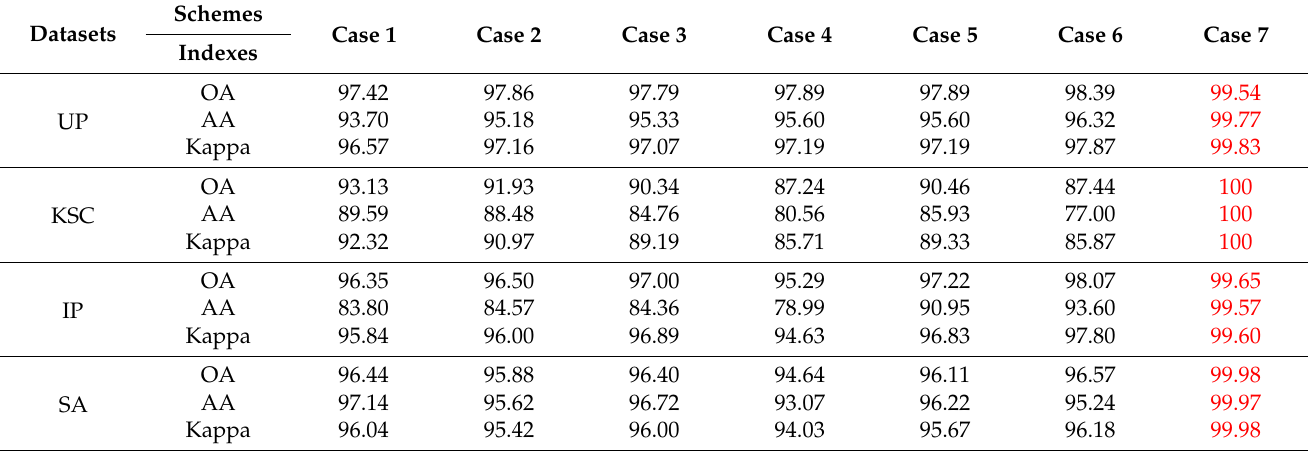
Table 10. Classification results of different fusion methods on four public datasets.